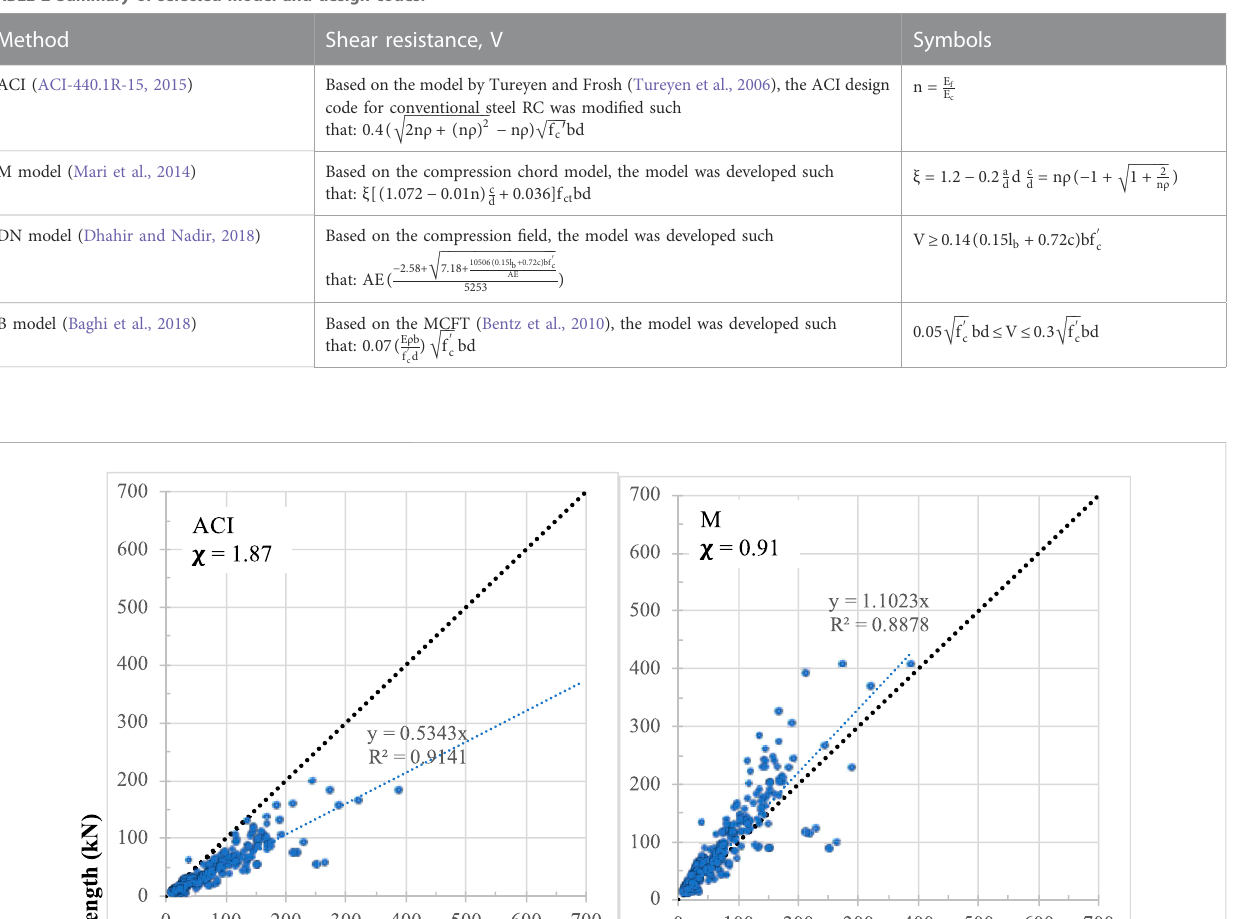
correlation between the calculated and measured strengths. The SR statistical measures include the minimum, maximum, average, coef fi cient of variation, and median. ACI is overly conservative, with a SR average value of 2.02 and a χ factor value of 1.87. The B